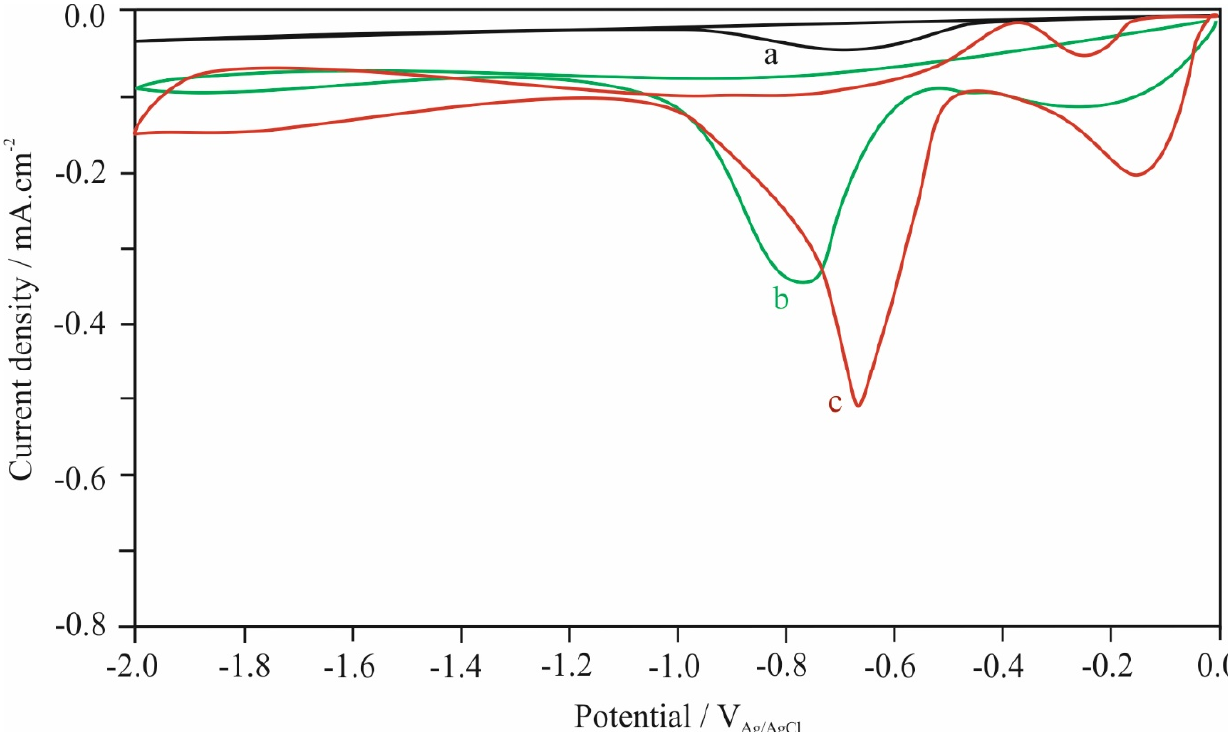
Figure 6. Cyclic voltammograms obtained in 0.1 M LiClO 4 acetonitrile solution at a scan rate of 0.01 V/s for (a) only, (b) 0.004 M compound 1 , (c) 0.004 M compound 2 .